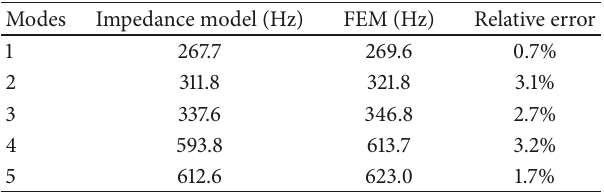
Table 3: Validation of the natural